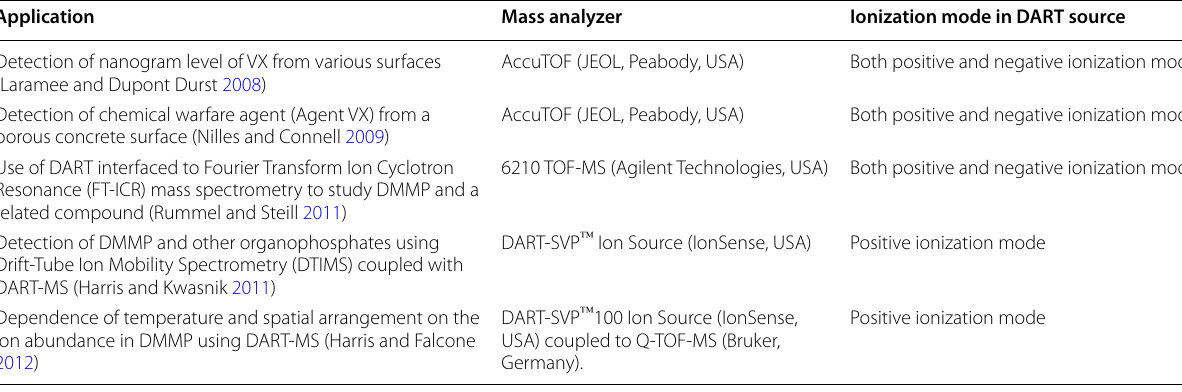
Table 8 Applications of various chemical warfare agents along with the type of mass analyzer used for their analysis